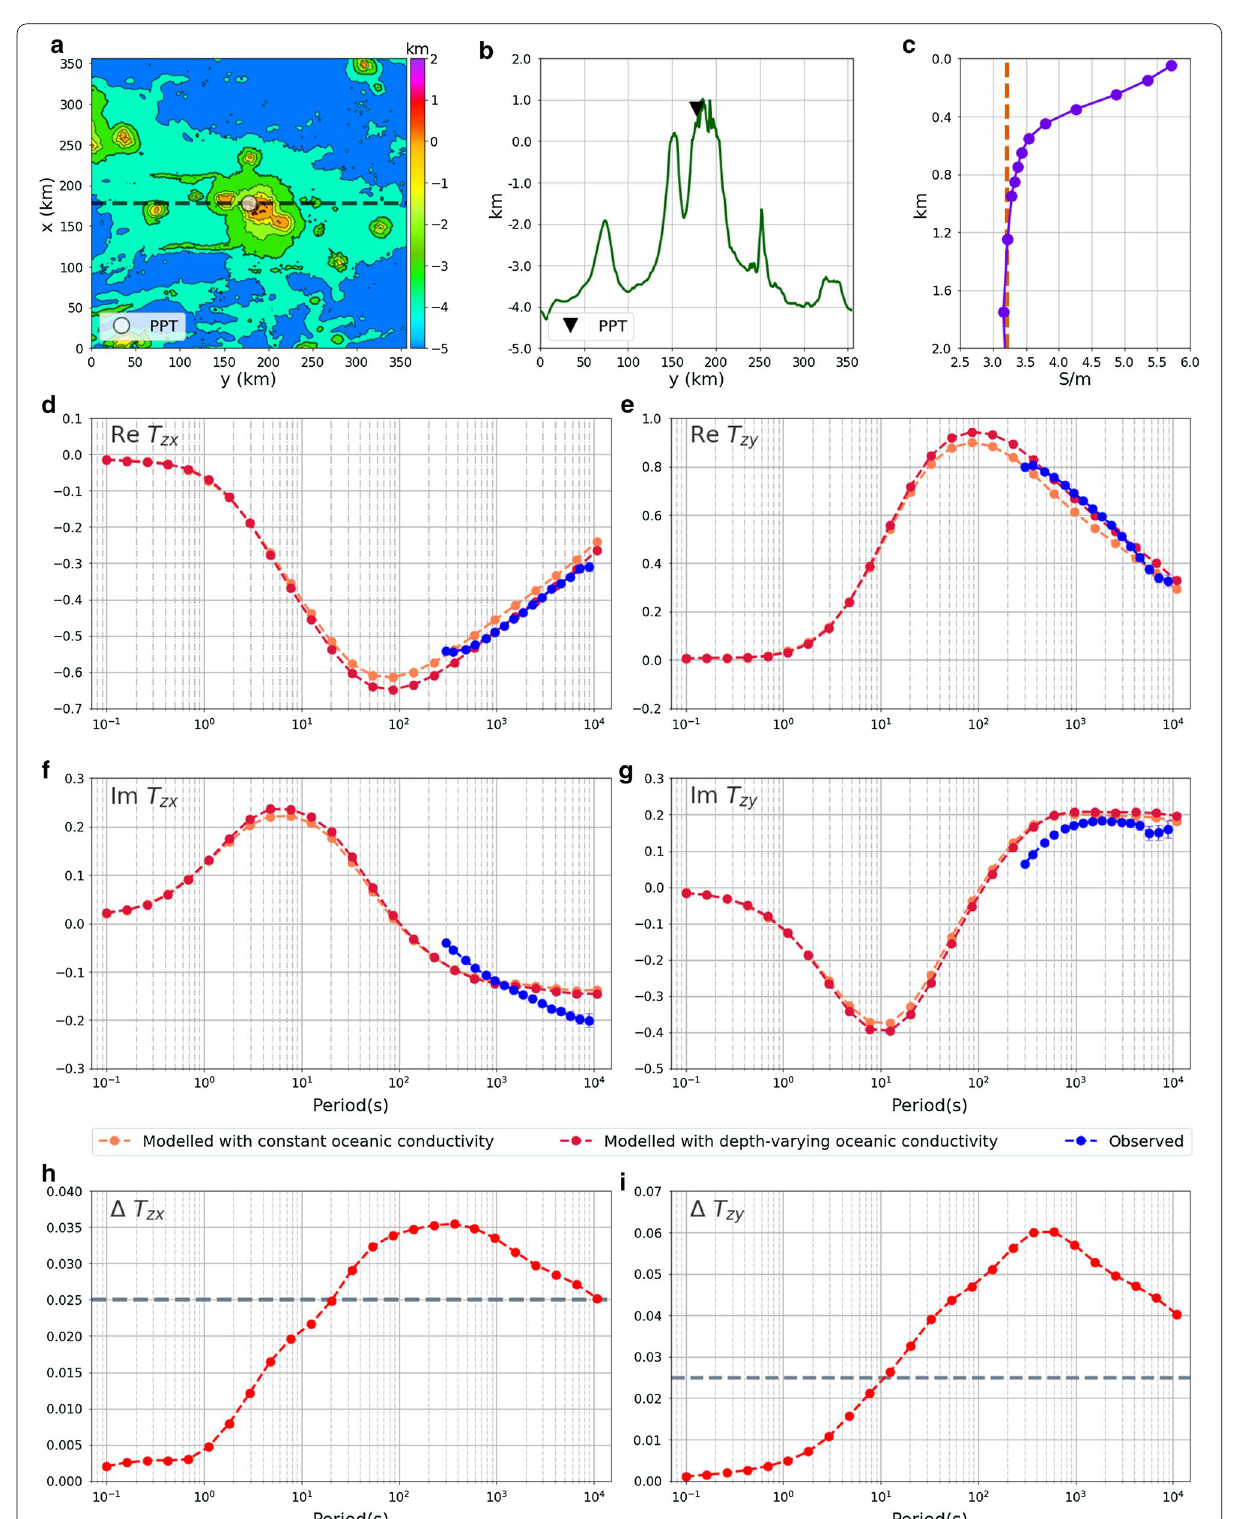
Fig. 12 Same as Fig. 5, but for Pamatai observatory